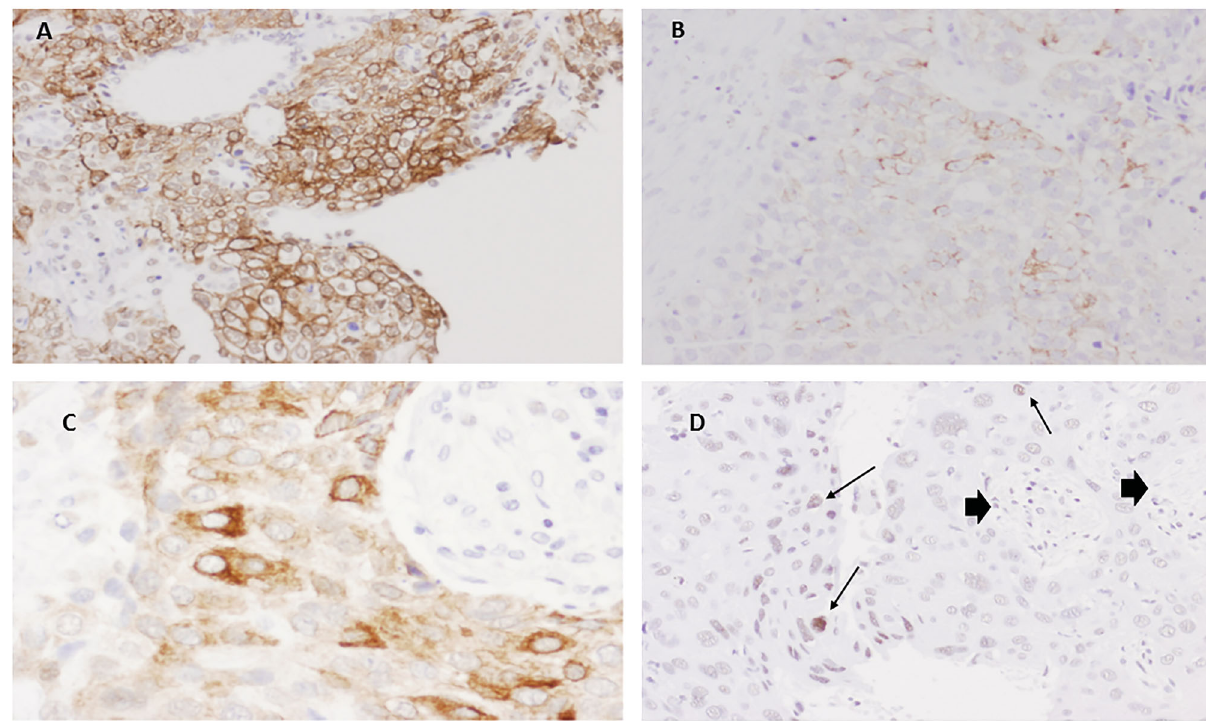
Figure 3. Immunohistochemistry for KRT15 in SCC. (A) Extensive positivity in well differentiated SCC in cell membranes (20 (cid:5) ). (B) Poorly differentiated area with focal membranous staining (20 (cid:5) ). (C) Area with predominant cytoplasmic staining (60 (cid:5) ). (D) Poorly differentiated SCC showing some nuclei with faint staining (arrows). Note negativity in stromal cells (arrow heads) (20 (cid:5) ).